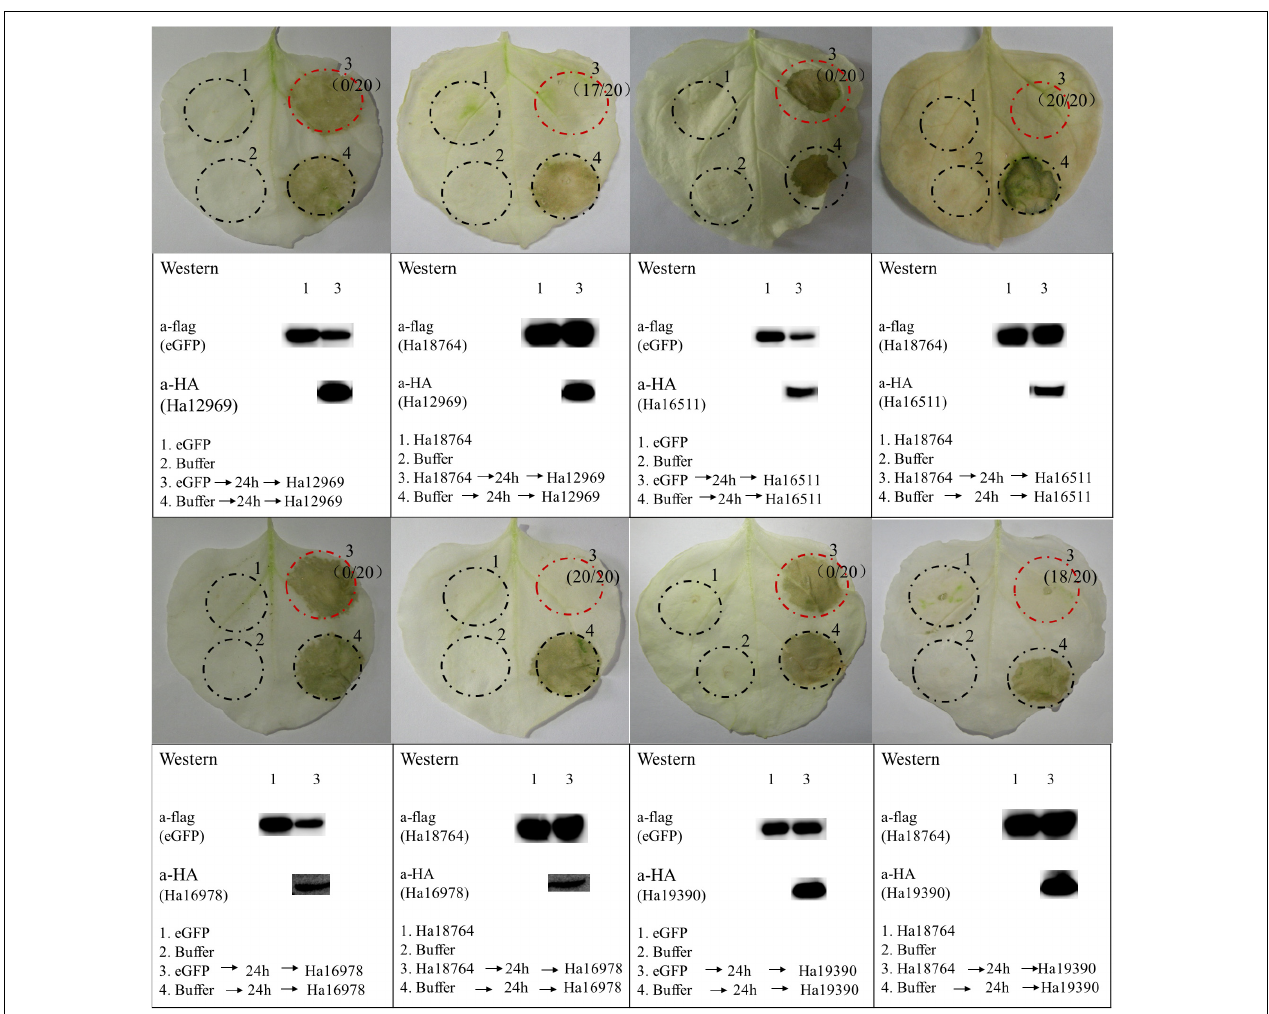
FIGURE 7 | Ha18764 suppress cell death triggered by other candidate Heterodera avenae effectors in Nicotiana benthamiana . Nicotiana benthamiana leaves were infiltrated with buffer or Agrobacterium tumefaciens cells carrying Ha18764 or the negative control, either alone or 24 h prior to infiltration with A. tumefaciens cells carrying the elicitors. Photographs of infiltrated leaves were taken ca. 4 days after the last infiltration. Four circles marked with Roman numerals represented regions injected with different A. tumefaciens , which is indicated under the photographs. The numbers in parentheses are the proportion of infiltrated sites showing cell-death-suppressing symptoms. Results for the verification of gene expression by Western blotting are shown below. The original Western blotting images for the verification of gene expression were provided in Supplementary Figures S5 , S6